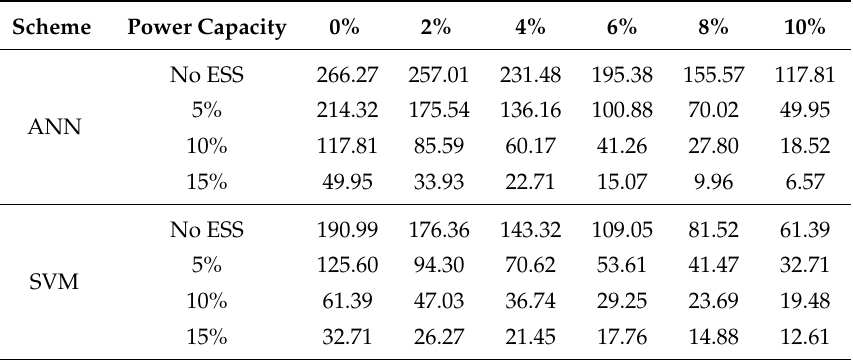
Table 5. Hourly deviation penalties [$/h] of both ANN and SVM schemes with different power capacities and tolerance limits.